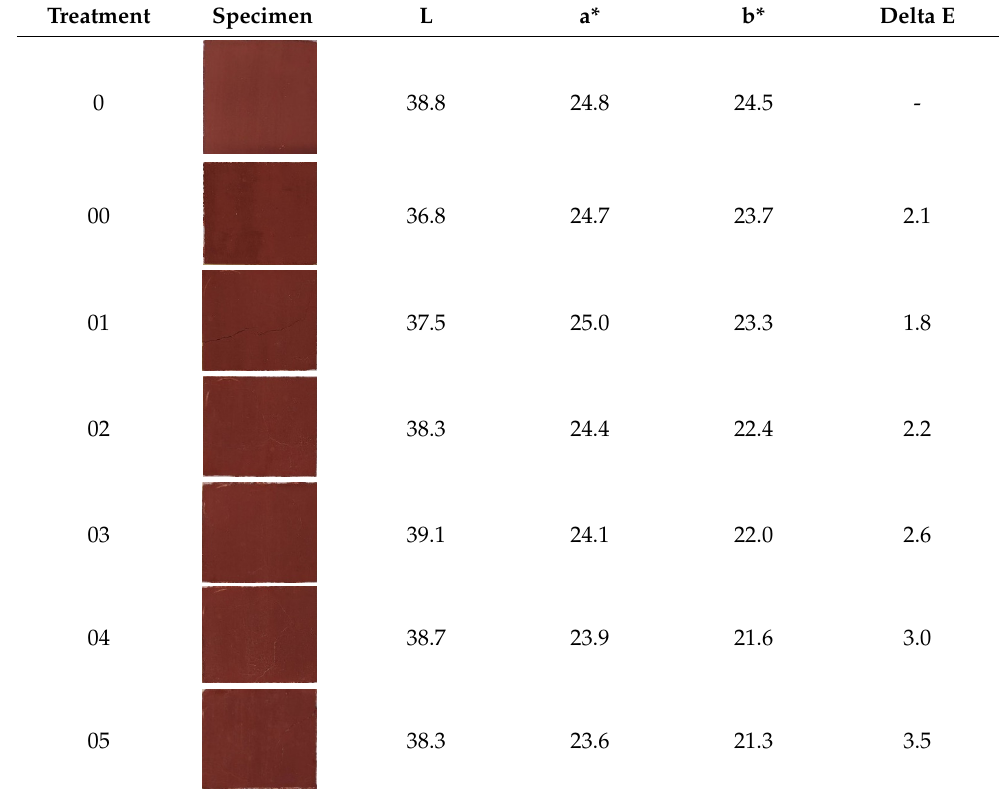
Table 4. The results of colorimetric test for the evaluation of chromatic changes after the application of different nanolime treatments.